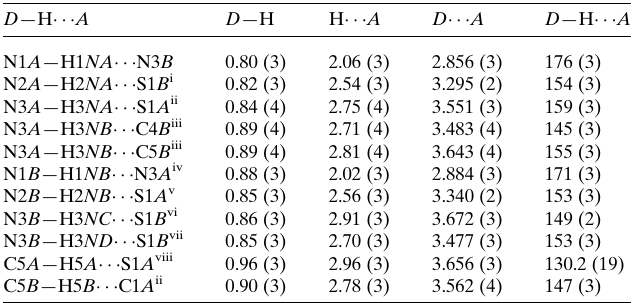
Table 1 Hydrogen-bond geometry (A˚ , (cid:3) ).